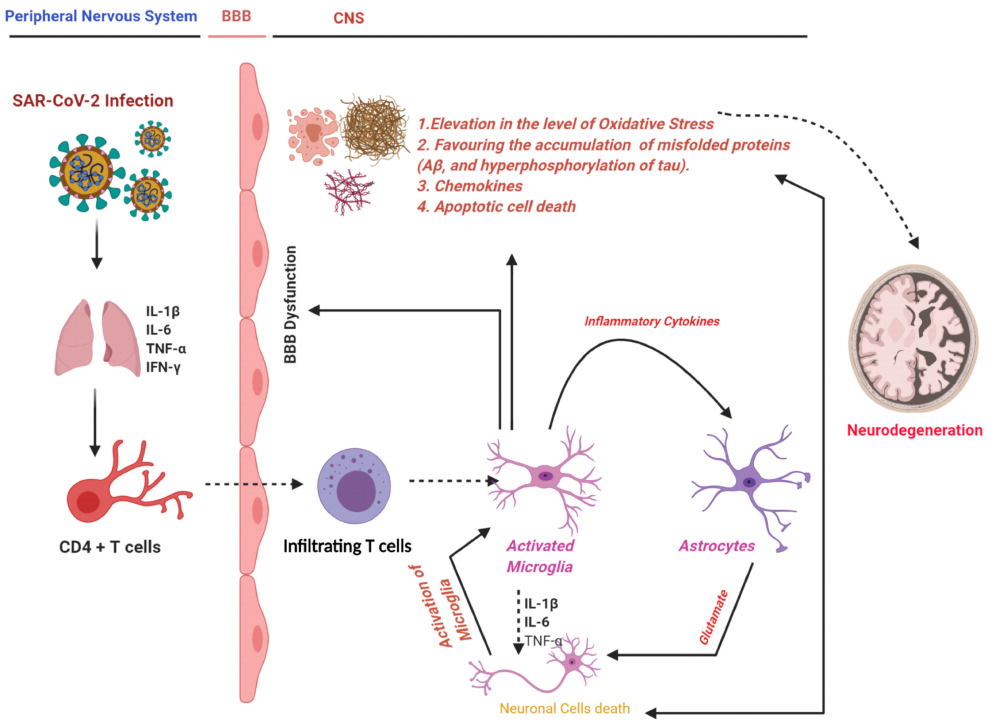
Figure 1. COVID-19 and